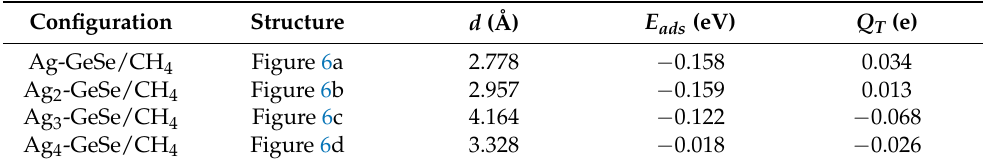
Table 2. Adsorption parameters of CH 4 gas molecules on Ag n -GeSe. Configuration